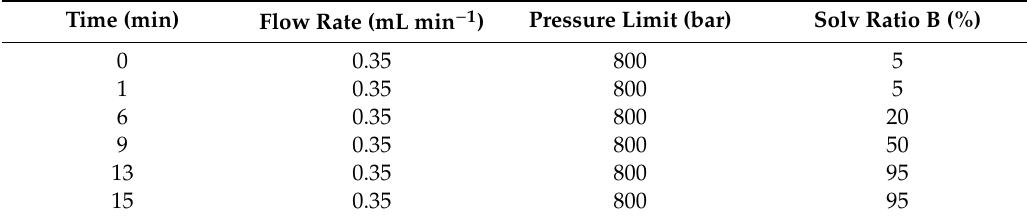
Table 1. Gradient of the mobile